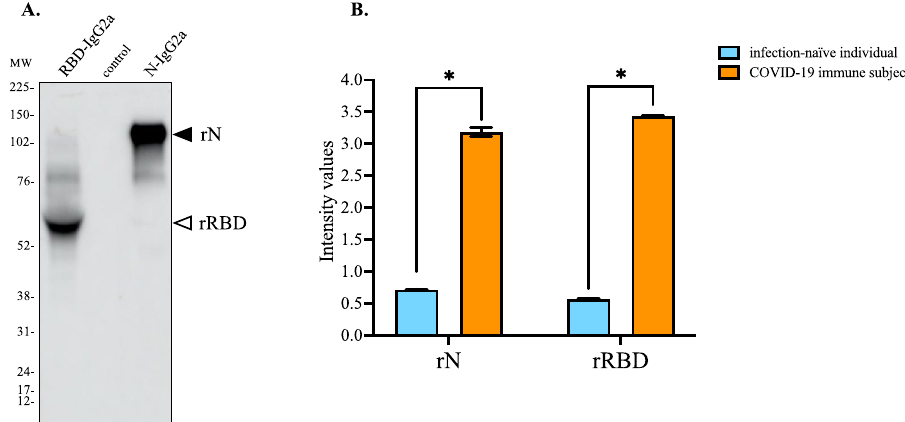
Figure 2. Antigenic reactivity of recombinant N and RBD proteins with human serum-specific SARS-CoV-2 antibody. In ( A ), CHO cells were transfected 72 h with plasmids expressing RBD-IgG2A (rN) and N-IgG2A (rRBD) proteins or empty vector plasmid (control). Aliquots of clarified cell culture supernatants (C3S) were analyzed by immunoblot assay using goat anti-mouse IgG heavy chain HRP antibody. The original full- length gel is presented in Supplementary Figure S1. In ( B ), pools of four COVID-19 donor serum samples (Table S2, serum donors n°16, 18, 19, and 20) (COVID-19 donor serum) and four negative donor serum samples (Table S3) (negative donor serum) at dilution 1:100 were tested for anti-N and anti-rRBD antibodies by indirect ELISA using rN and rRBD for protein-based antibody capture. The intensity values of serum samples were measured at O.D. 450 nm. The results are the mean (± SEM) of three replicates. Unpaired t tests between COVID-19 immune subject and infection-naïve individual were performed and statistically significant comparisons are shown as * p < 10 –4